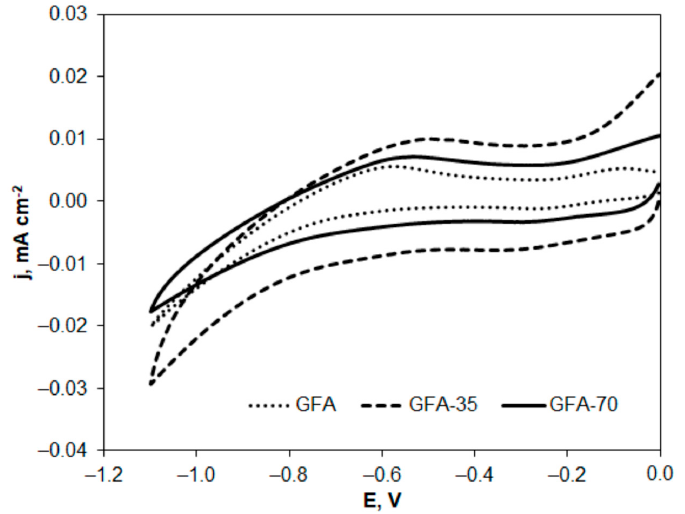
Figure 7. Cyclic voltammograms of 4-chlorophenol solution (1 × 10 − 3 mol L − 1 in 0.05 mol L − 1 Na 2 SO 4 ) Na 2 SO 4 ) electrooxidation recorded at GFA electrodes; v = 20 mV s − 1 . electrooxidation recorded at GFA electrodes; v = 20 mV s − 1 .